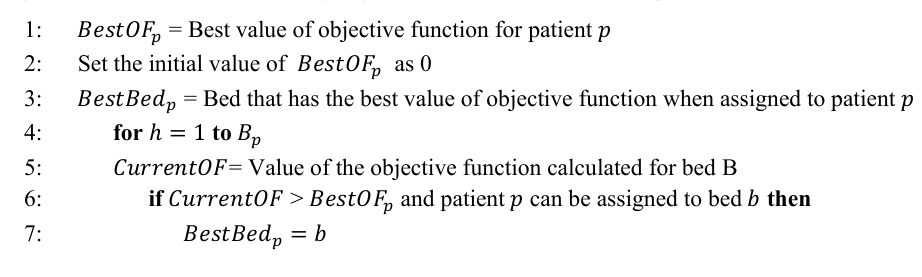
Algorithm 1. Pseudocode for assigning the best-suited bed 𝑏 ∈ 𝐵 for patient 𝑝 ∈